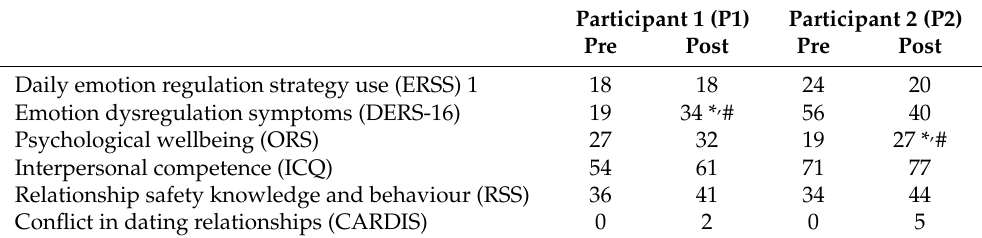
Figure 5. Relationship Safety changes from phase A to B for P2. Table 5. Pre and post treatment